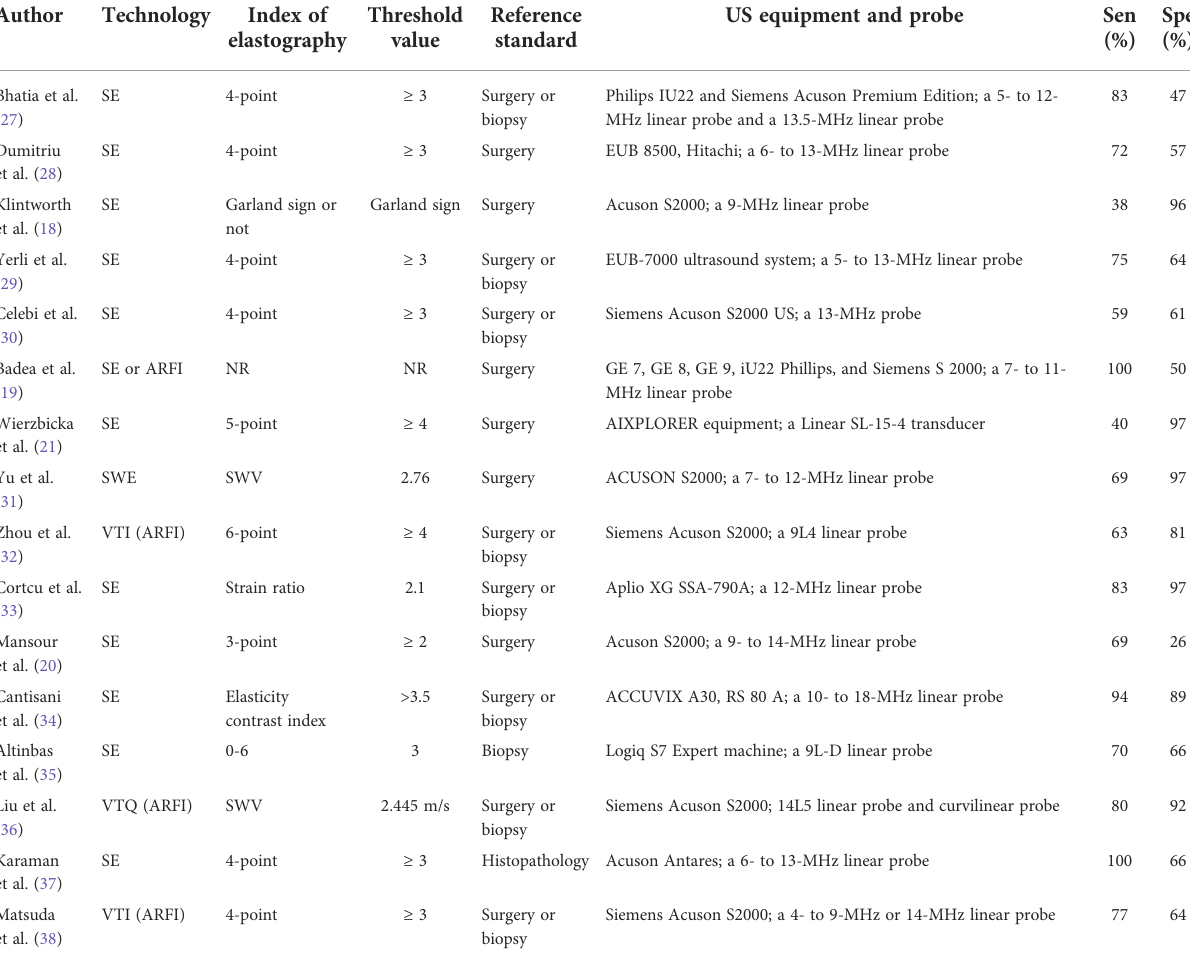
TABLE 2 Characteristics of the included